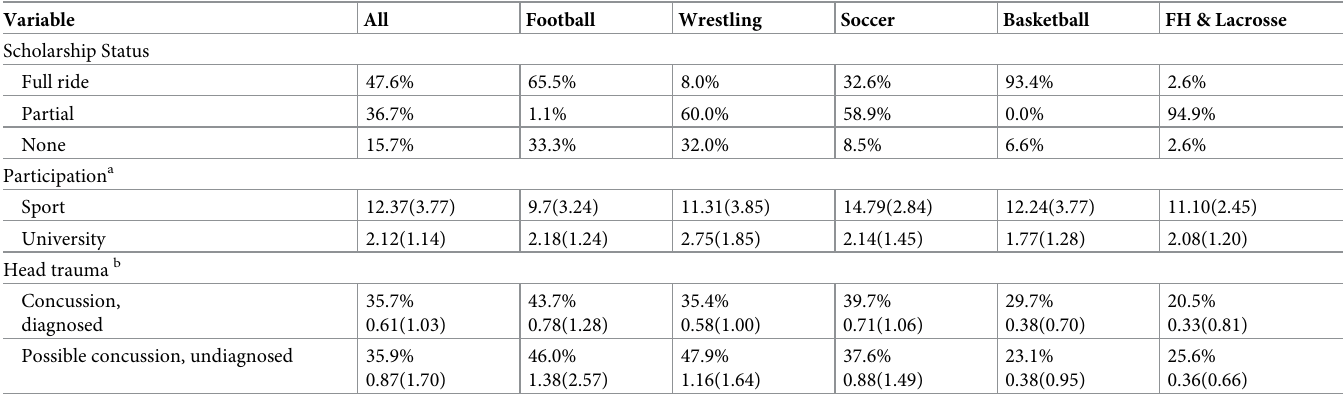
Table 1. Scholarship, participation, and head trauma by sport.